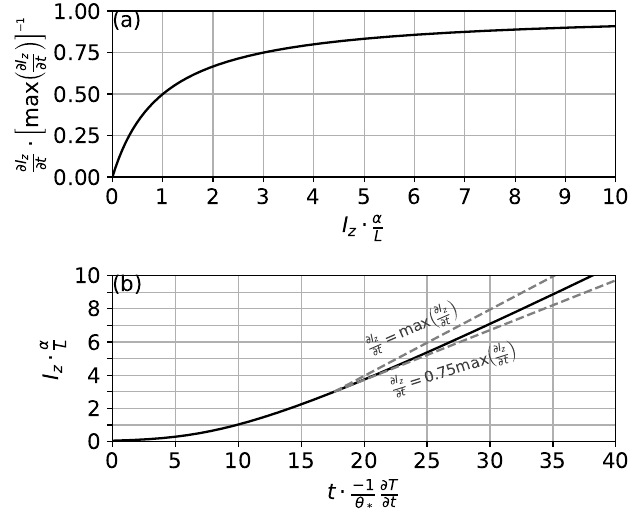
Figure 2. Fog growth in a quasi-steady stable boundary layer. ( a ) The rate of growth as in Equation (11). ( b ) The value of I z in time. The dashed lines indicate the linear growth rate at I z = 3 L / α and the maximum growth